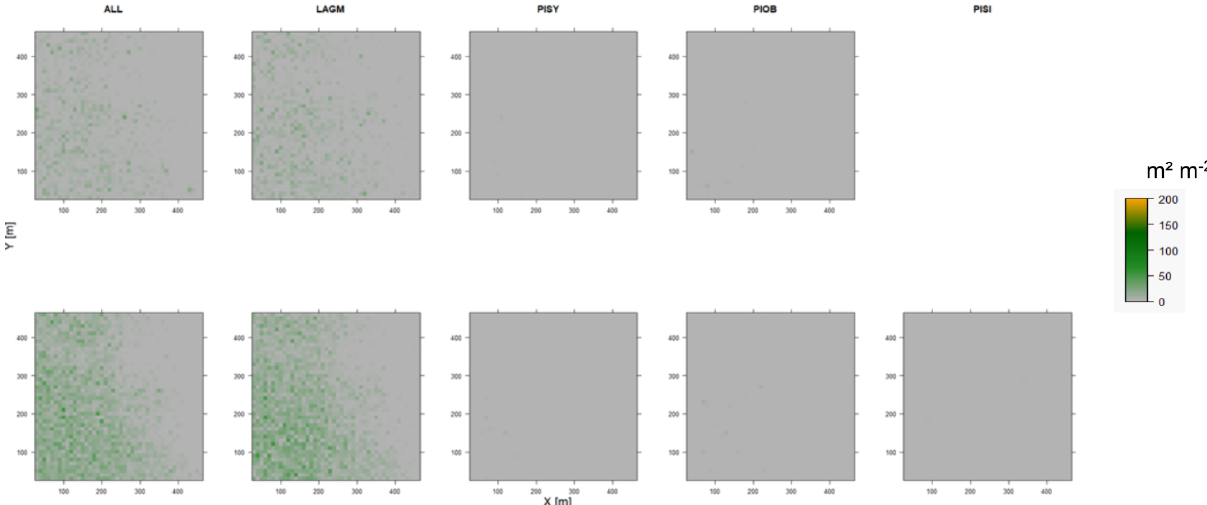
Figure D11. Leaf area index (LAI) values of the CryoGrid grid aggregated at year 2025 at Spasskaya Pad. Upper row shows LAVESI– CryoGrid coupled; lower row shows LAVESI simulations. LAGM: Larix gmelinii ; PIOB: Picea obovata ; PISI: Pinus sibirica ; PISY: Pinus sylvestris . Simulations with PISI coupled were not possible.